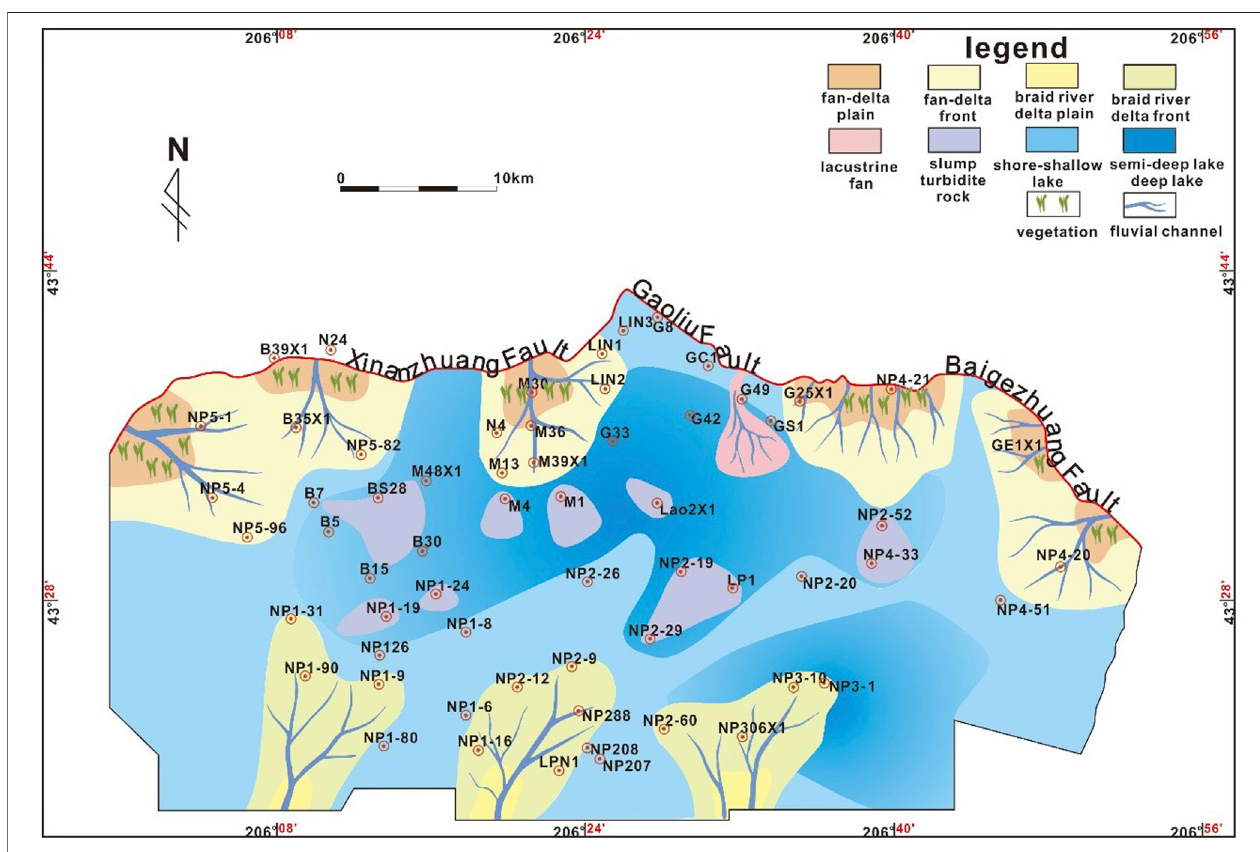
FIGURE 6 | Plane distribution map of the E d 2 sedimentary system in Nanpu